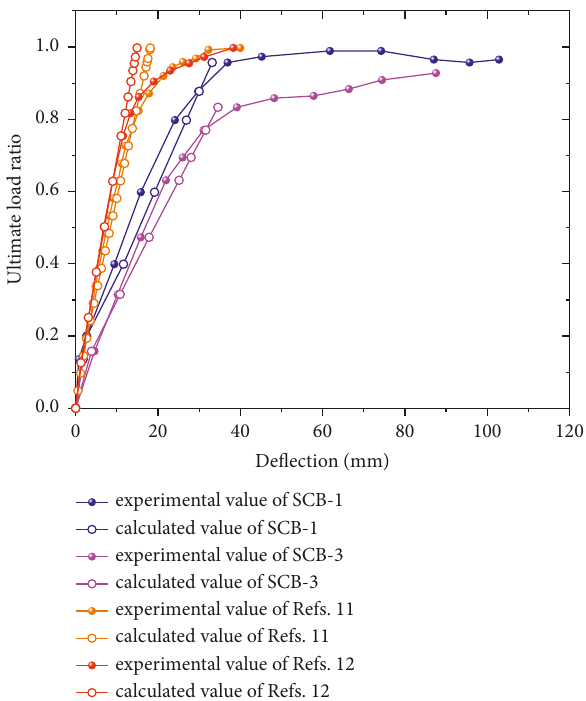
Figure 11: Comparison of deflection data of inverted beams.